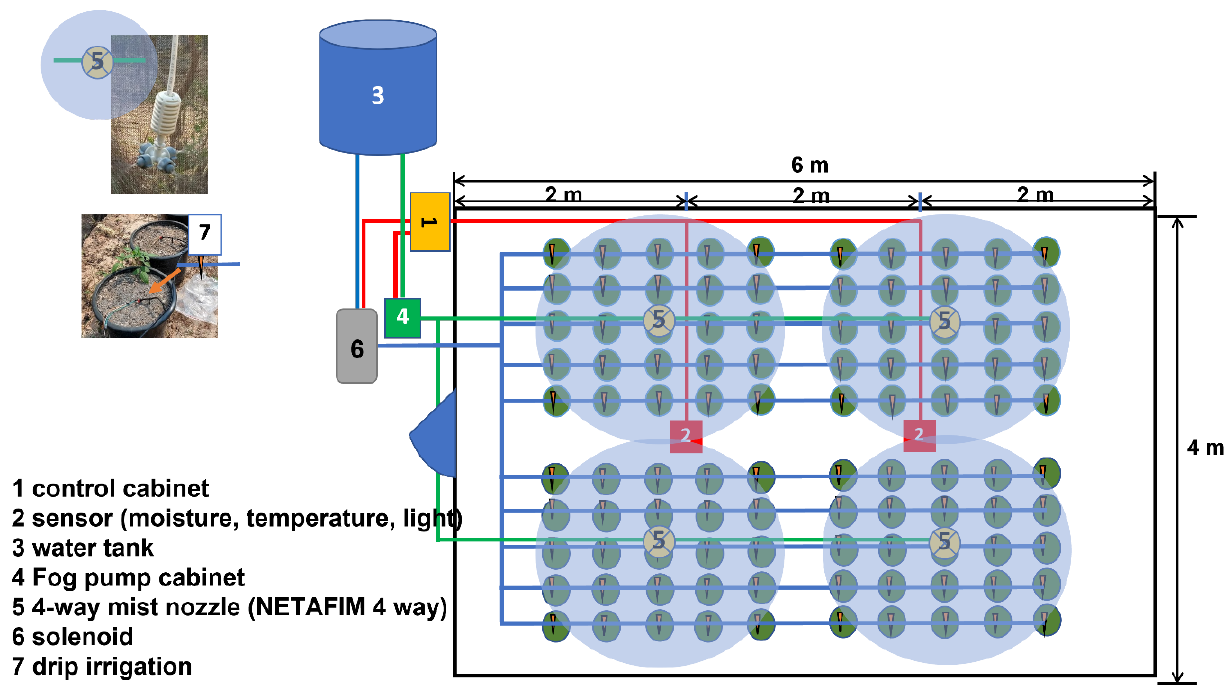
Figure 2. Schematic diagram of IoT-operated irrigation system in a greenhouse. IoT Irrigation System